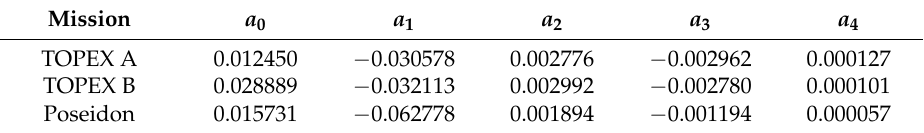
Table 2. Coefficients of BM4 model for satellite altimetry